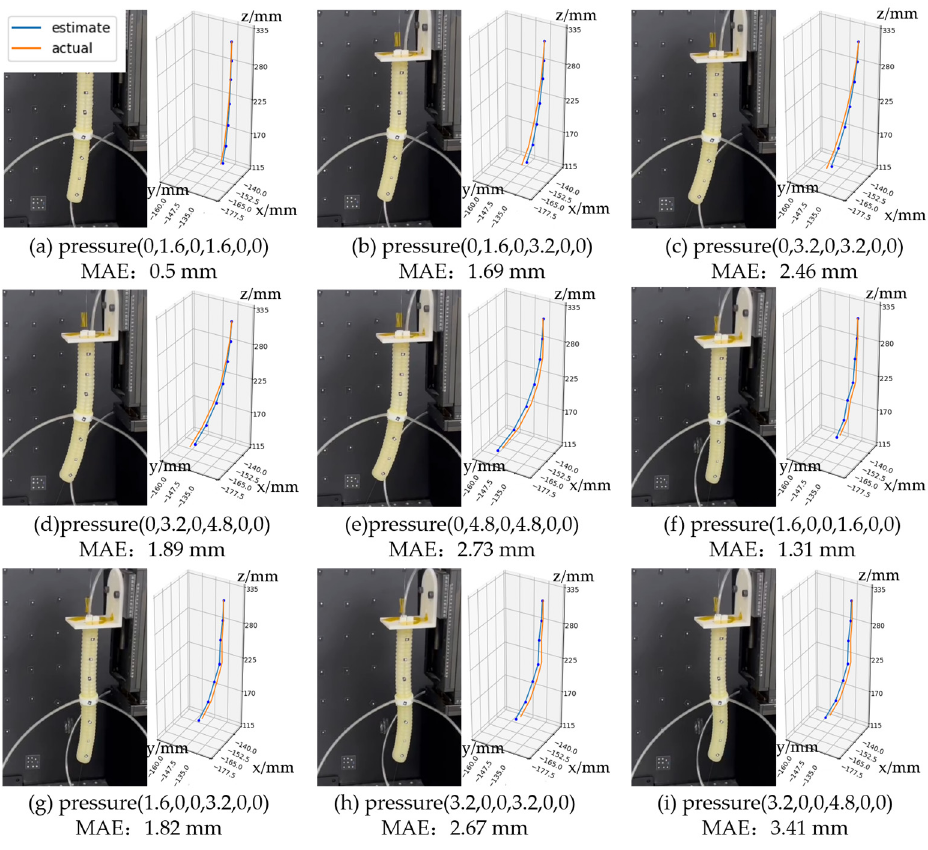
Figure 8. Posture sensing of the manipulator under certain pressure input conditions (kPa). The manipulator’s outside posture was reconstructed using the LSTM network model’s output information (Appendix B).